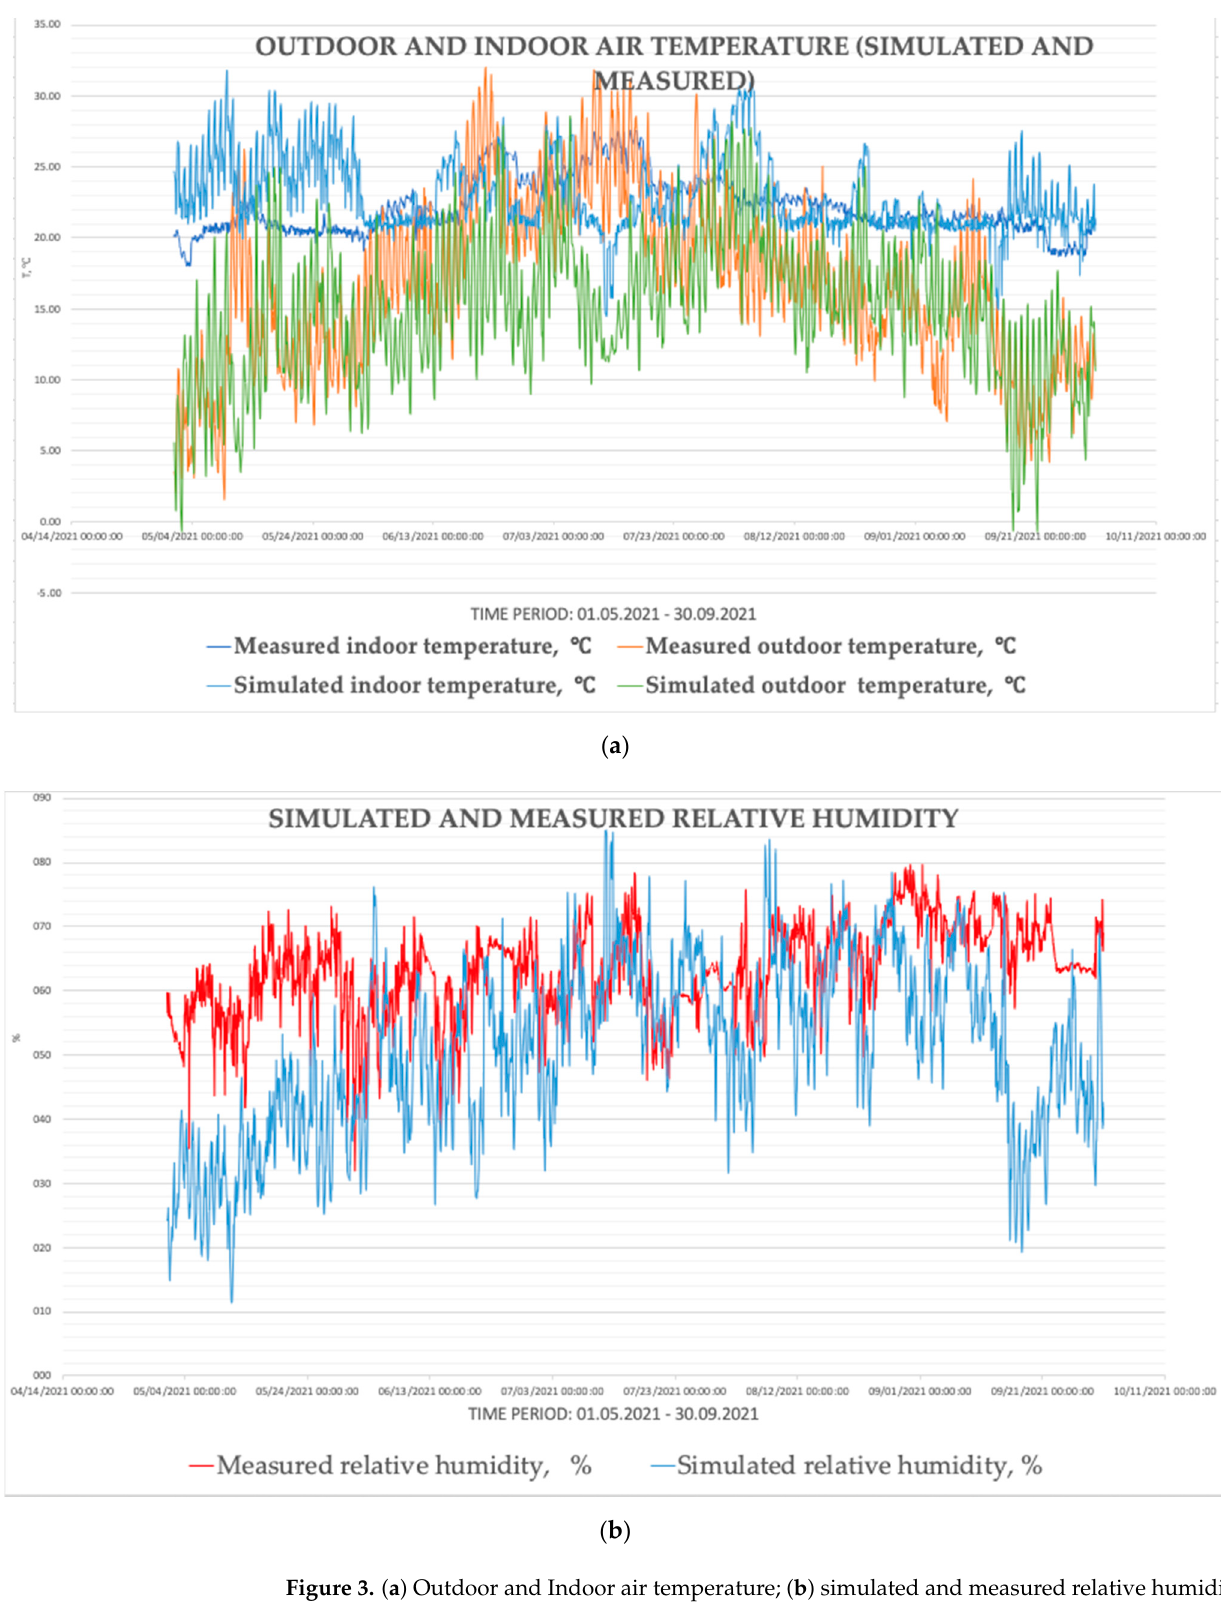
Figure 3. ( a ) Outdoor and Indoor air temperature; ( b ) simulated and measured relative humidity. The climate data and wind profile are used according to ASHRAE 2013. The building data used in the energy analysis are presented in Table 1. Calculations are taken from the